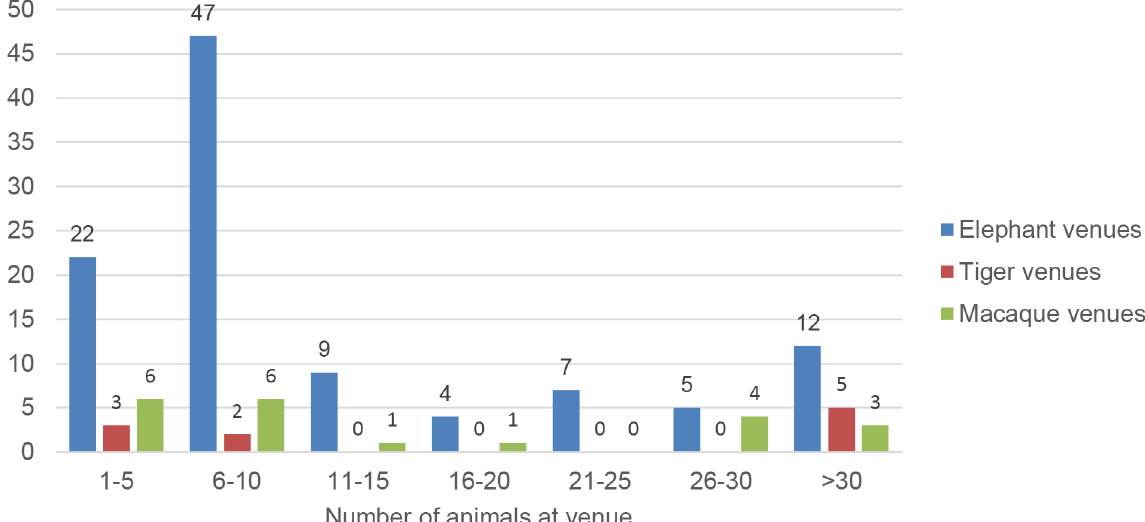
Fig 1. Sizes of venues based on animal numbers. Grouping venues based on the numbers of elephants kept on site at the time of the assessment, shows more than half of the elephant venues being of smaller scale. Most venues were keeping between 6 – 10 elephants, followed by small scale venues with 1 – 5 elephants. At the other range of the spectrum 12 venues housed more than 30 animals at their premises. Tiger and macaque venues showed concentrations of venues at either end of the scale but with very few medium sized venues.